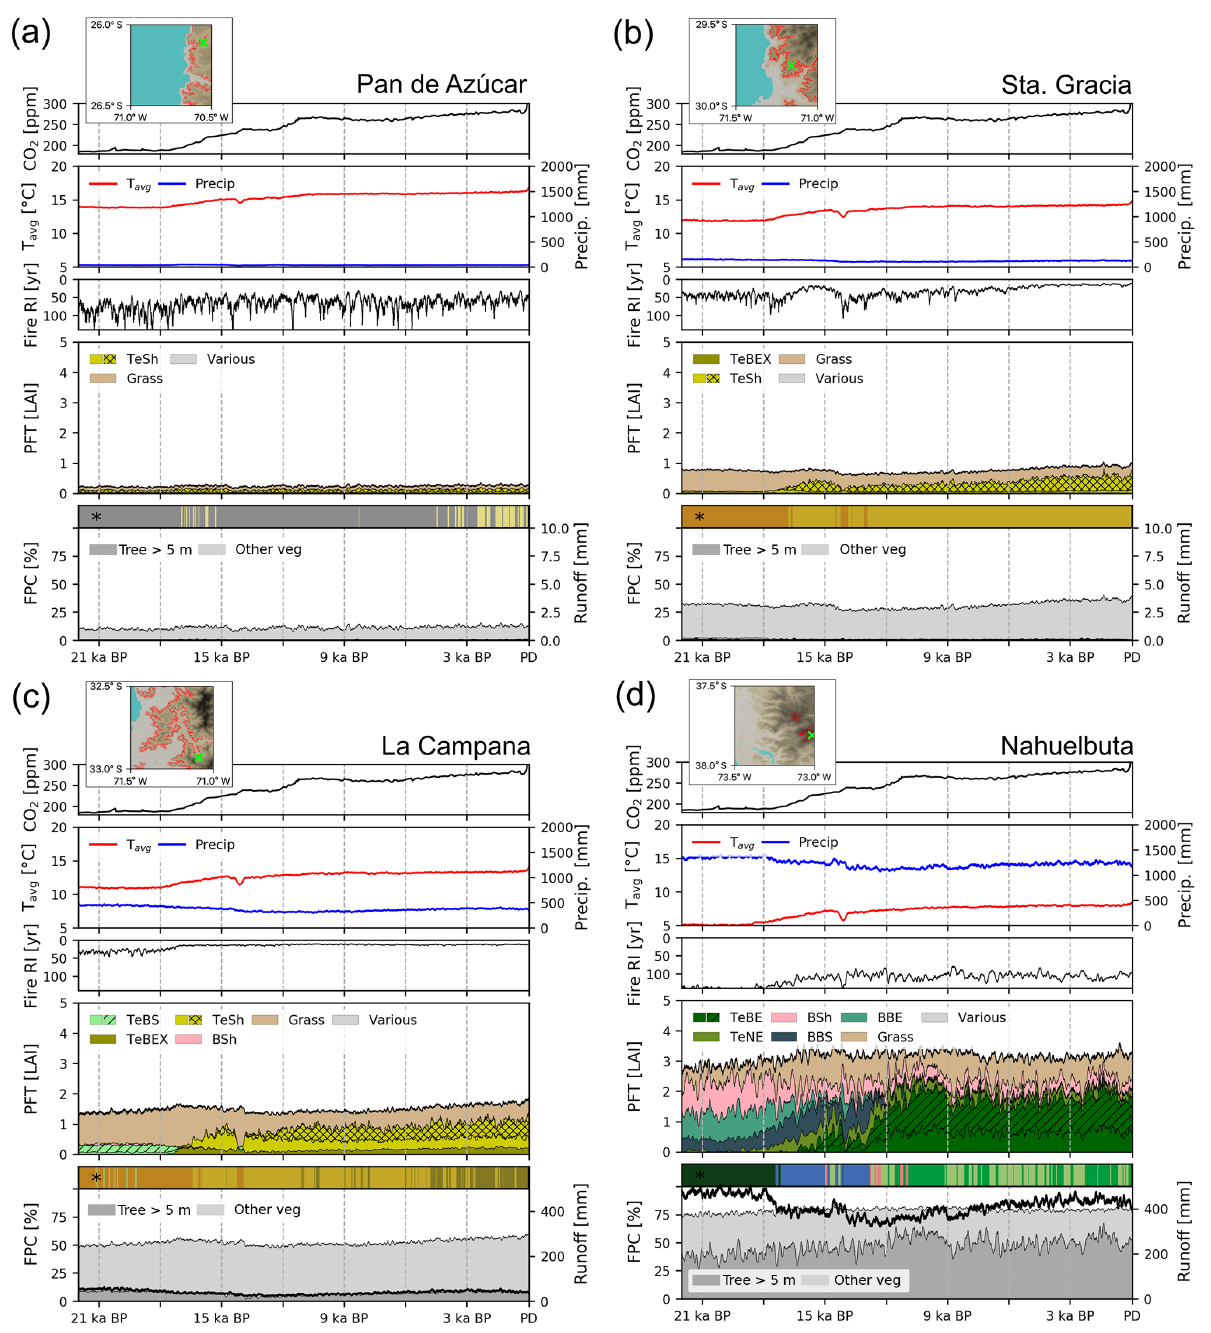
Figure 9. Transient simulations for the (a) Pan de Azúcar, (b) Sta. Gracia, (c) La Campana, and (d) Nahuelbuta sites. The insets show the location within the simulated 0 . 5 ◦ × 0 . 5 ◦ grid cell and the area and location covered by the landform plotted in this figure (results given in other figures are an area-weighted aggregation of individual landform simulation results). Panels 1–3 (from top to bottom): “ T avg ” is annual average temperature, “Precip” is annual precipitation, “Fire RI” is fire return interval. Panel 4: “PFT” is plant function type; (grouped) PFT abbreviations: “TeSh” is temperate shrubs, “Grass” is herbaceous vegetation, “TeBEX” is sclerophyllous temperate broad-leaved evergreen trees, “TeBS” is temperate broad-leaved summergreen trees (hashed represents shade-intolerant), “BSh” is boreal evergreen shrubs, “TeBE” is temperate broad-leaved evergreen trees, “TeNE” is temperate needle-leaved evergreen trees, “BBS” is boreal broad-leaved summergreen trees, “BBE” is boreal evergreen trees, “Various” refers to other PFTs (LAI<0˙.05); plain represents shade-intolerant, hatched represents shade-tolerant, cross-hatched represents raingreen. Panel 5: “FPC” is foliar projected cover; trees and shrubs >5m are denoted using dark gray, herbaceous vegetation and small trees and shrubs are denoted using light gray. “Runoff” is simulated surface runoff; ∗ Biomization: for a legend on the applied classification see Figs. C1 and 4 for a color-coded legend. All data smoothed using 100-year averaging. Earth Surf. Dynam., 6, 829–858, 2018